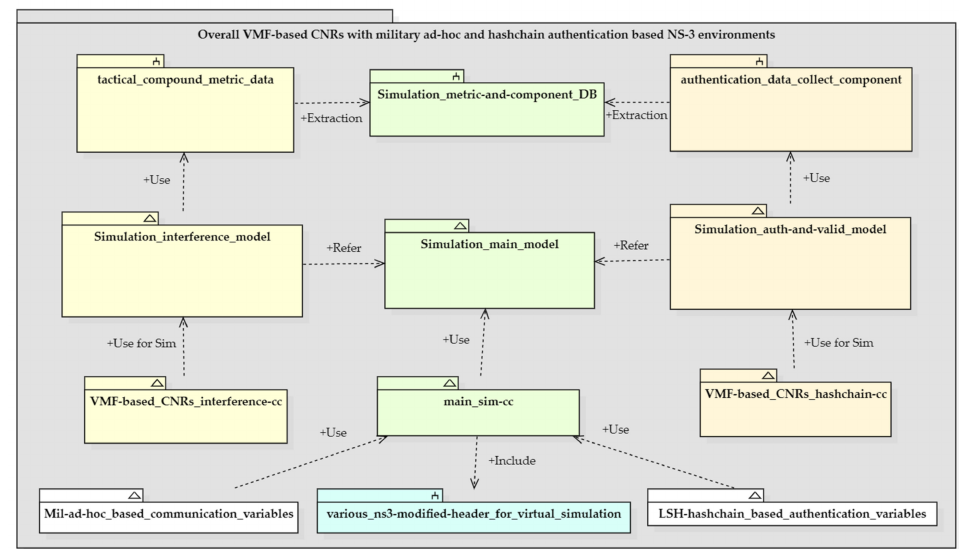
Figure 10. Overview of overall VMF-based CNR testbed architecture with hash chain authentication.